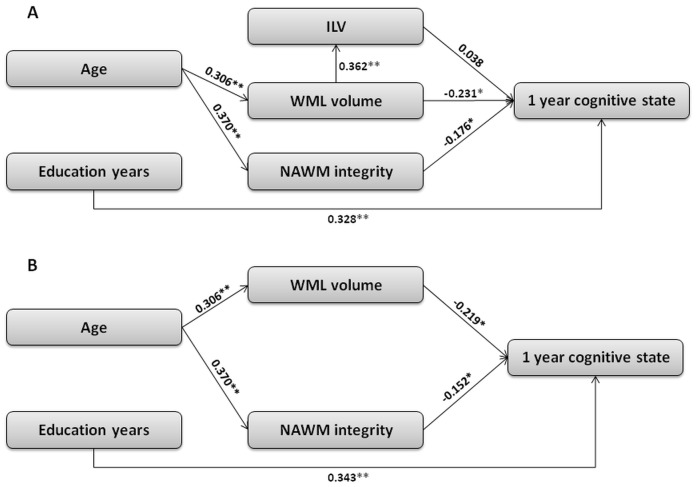
Structural equation models for the prediction of cognitive state after one year.Subtext: The numbers on the arcs represent the contribution of each parameter to its neighbor. * p<0.05 **p<0.001. Abbreviations: ILV, ischemic lesions' volume; WML, white matter lesions; NAWM, normal appearing white matter.